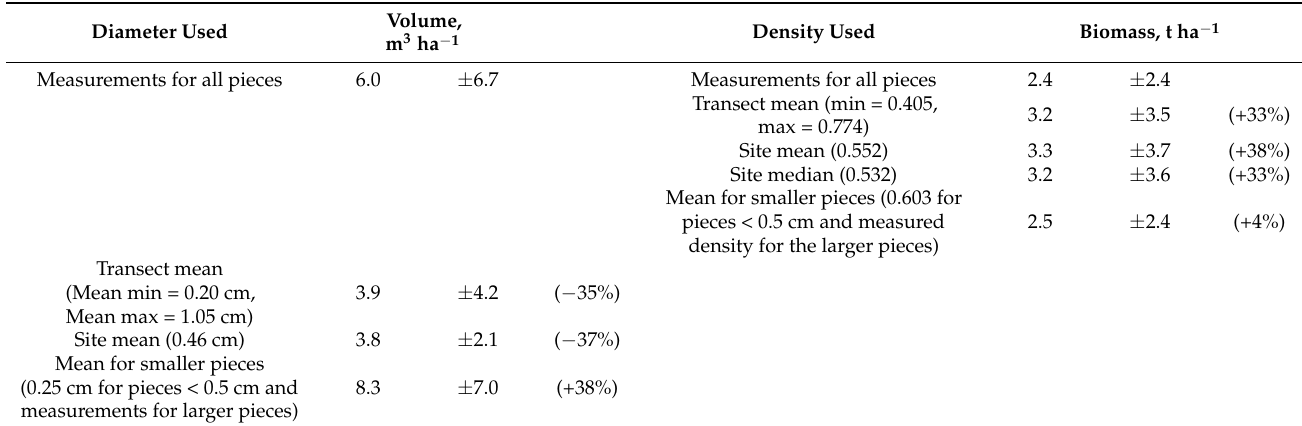
Table 4. For the line-intersect sampling (LIS) method in the Pilot Stand, comparison of volume and biomass estimates based on the measurement (diameter or wood density) of all pieces, or based on the mean per transect (n = 23, mean ± SD, and percentage of difference compared to the measurement of all pieces) or the mean per site. Volume, Diameter Used m 3 ha −